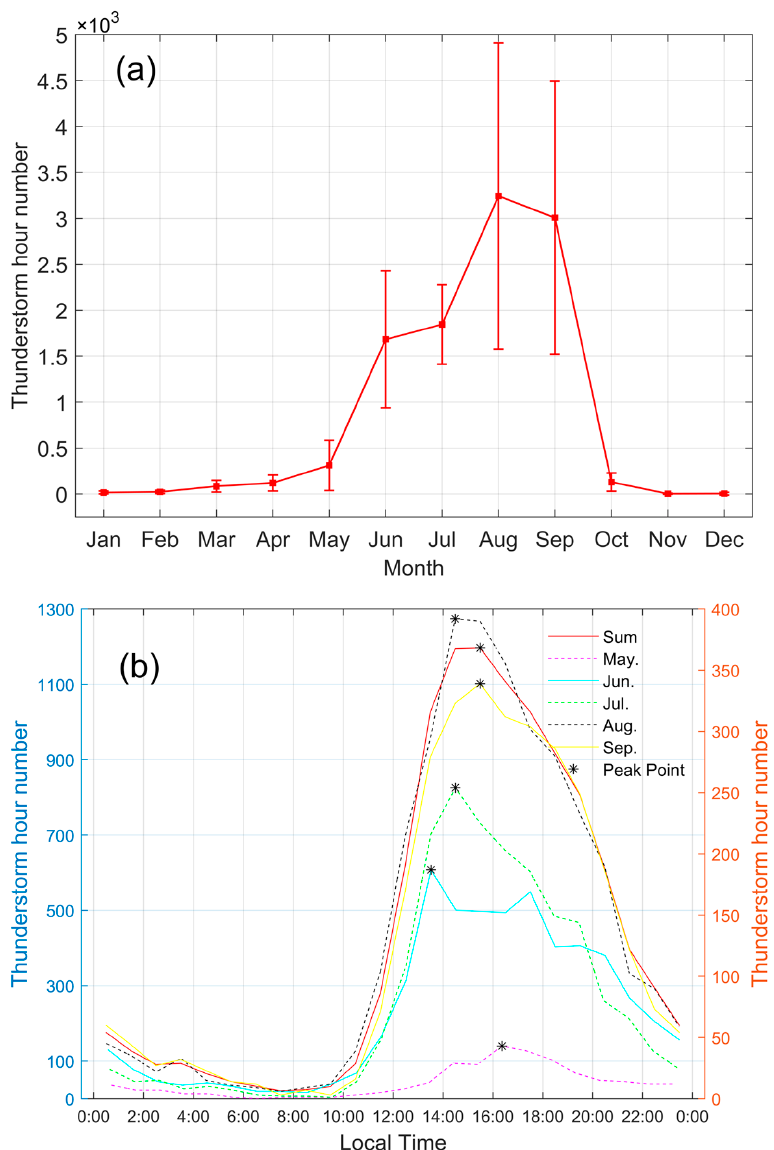
Figure 10. Monthly variation ( a ) with error bars and diurnal variation ( b ) in extreme-lightning thunderstorms on the QTP.